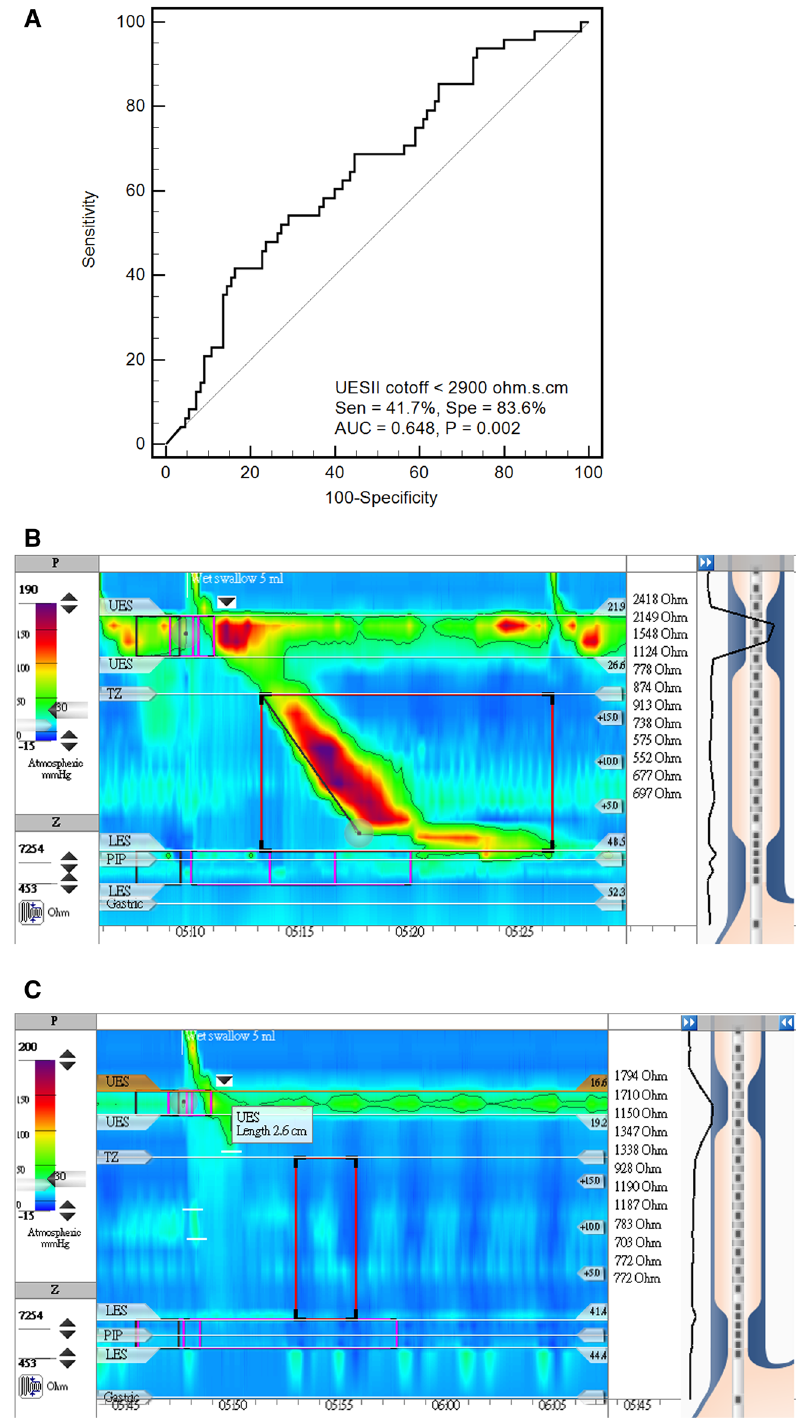
Figure 3. ( A ) The ROC analysis indicated that a upper esophageal sphincter impedance integral (UESII) cutoff of 2900 Ω s cm achieved the best differentiation between subjects with reflux symptom index (RSI) score > 13 and others with RSI score ≦ 13. ( B ) A subject with RSI score = 0 had the impedance value of 2418 Ω above upper esophageal sphincter immediate after 5 mL saline liquid swallow. ( C ) A subject with RSI score = 42 had the impedance value of 1794 Ω above upper esophageal sphincter immediate after 5 mL saline liquid